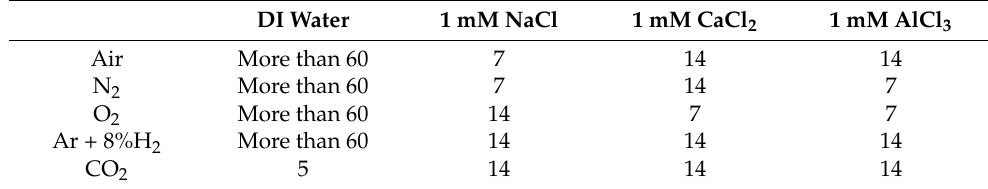
Table 2. Stable days of gas nanobubbles produced in different solutions. The minimum days are